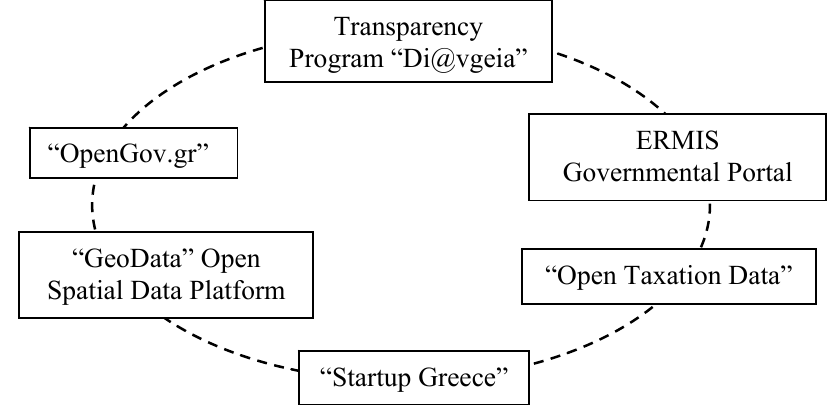
Figure 2. Main open governance actions of the Greek government in the context of OGP initiative